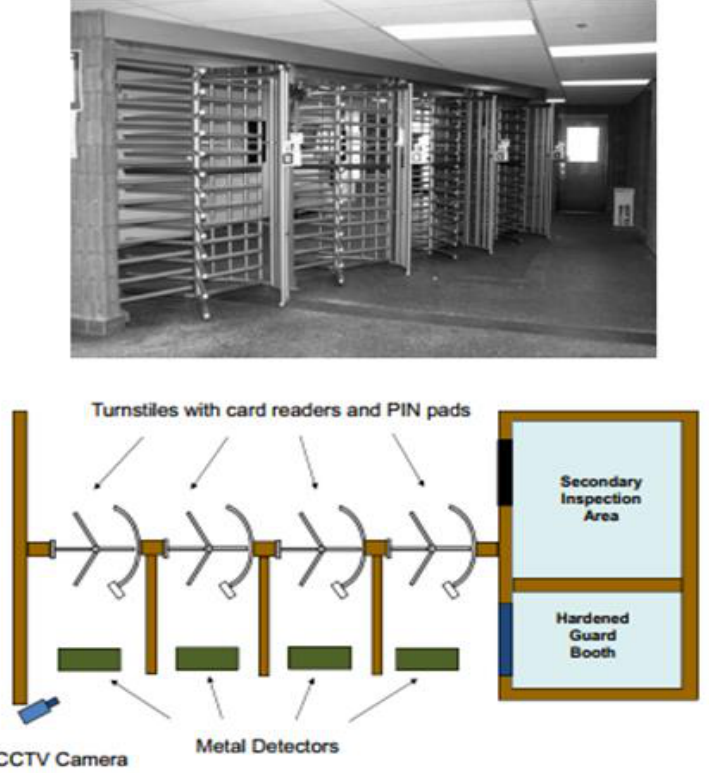
Figure 14. Typical personnel entry portal. The portal uses a magnetic card and pin combination to grant entry [20]